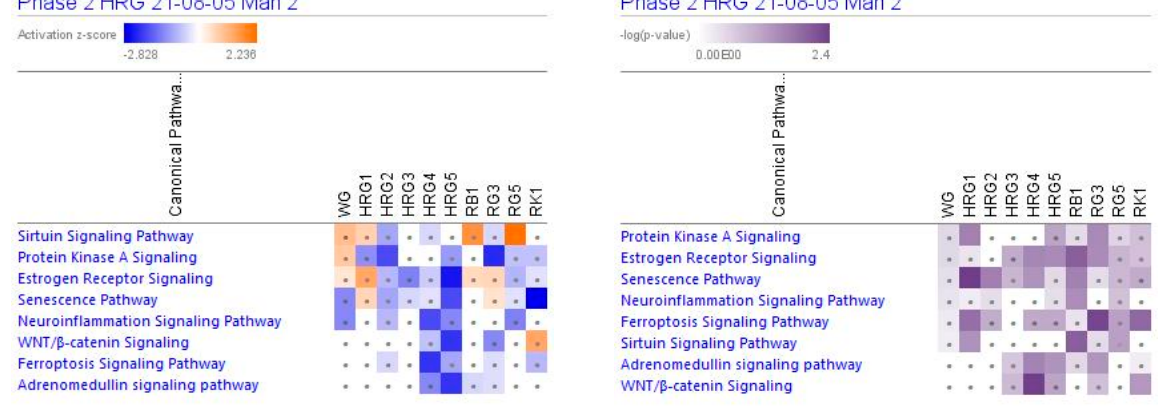
Figure 2. Effects of ginseng extracts WG (10 µ g/mL), HRG at concentrations of 10 µ g/mL (HRG1), 1 µ g/mL (HRG2), 100 ng/mL (HRG3), 10 ng/mL (HRG4), and 10 pg/mL (HRG5), and ginsenosides Rb1, Rg3, Rg5, Rk1 at a concentration 100 nM on selected canonical pathways. The brown color shows the predicted activation and the blue color the predicted inhibition of diseases; symbol · shows that the activation z-score was < 2 and a -log p -value < 1.3 = p < 0.05. An absolute z-score ≥ 2 is considered significant activation (+) or inhibition ( − ). The activation z-score predicts the activation state of the canonical pathway, using the gene expression patterns of the genes within the pathway. The p -value calculated using a right-tailed Fisher’s exact test indicates the statistical significance of the overlap of analyzed dataset genes that are within a pathway.